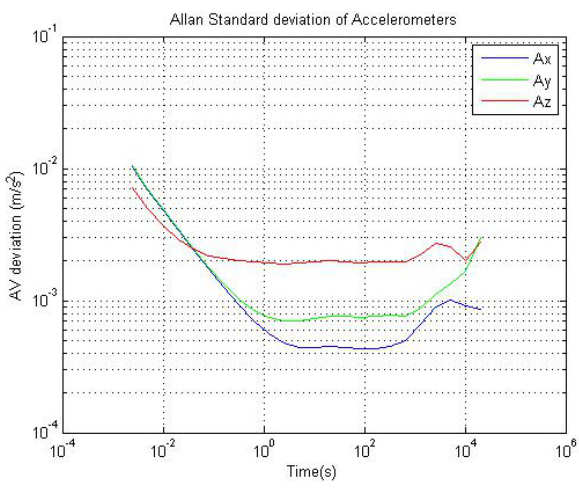
Figure 1: Allan variance for the EPSON accelerometers